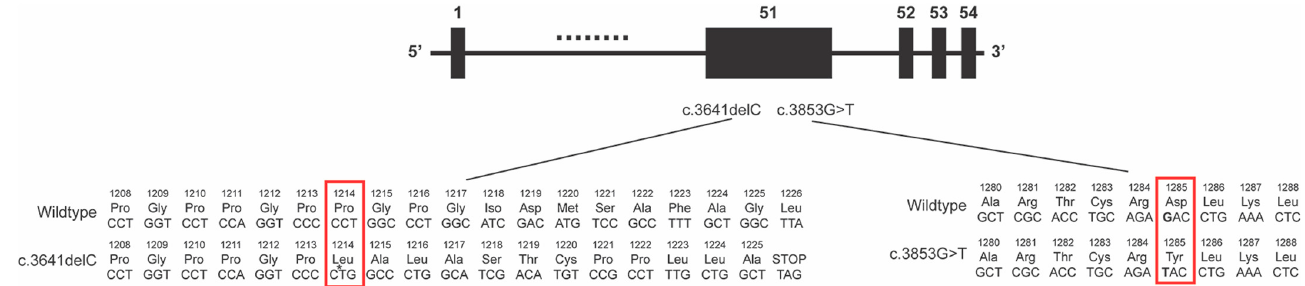
Figure 5. Effects of COL2A1 mutations in Exon 51 on protein sequence. Both the c3641delC and c.3853G>T mutations affect exon 51 in the COL2A1 gene. The c.3641 deletion from the